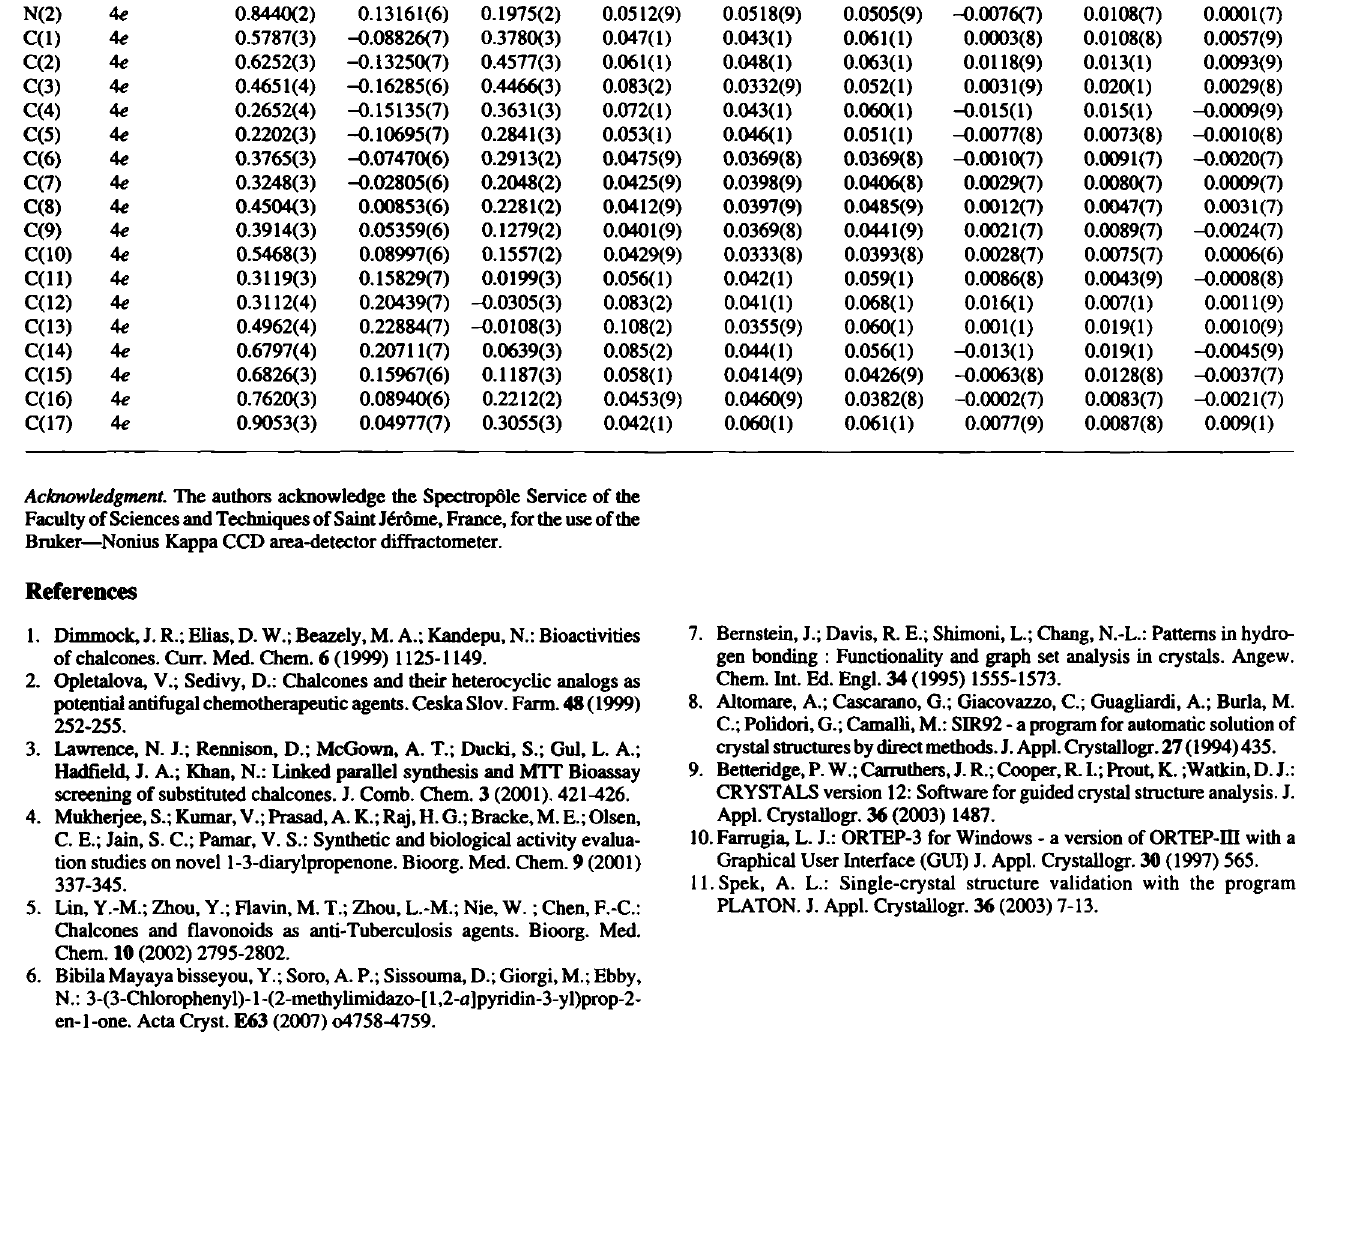
Table 3. Atomic coordinates and displacement parameters (in Â 2